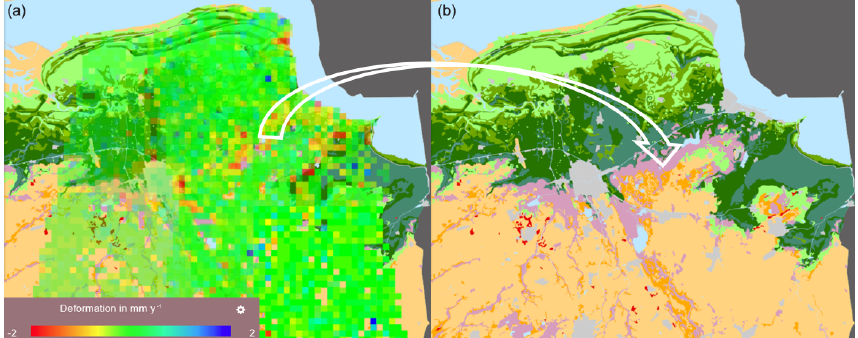
Figure 4. Shallow compaction rates (mmyr − 1 ) computed by PS separation based on height above ground level (a) , and soil composition (b) . The strip with shallow compaction rates of 1–2mmyr − 1 corresponds with the location of peat layers (pink). Source: SkyGeo